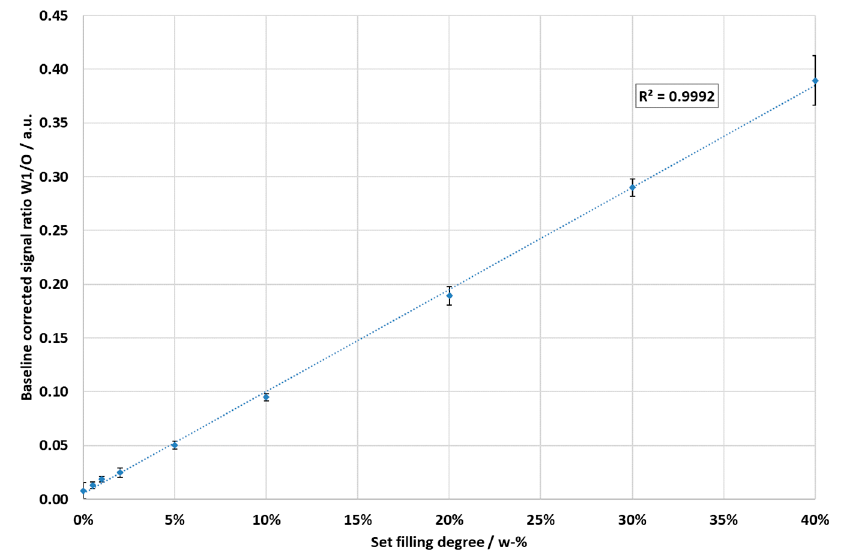
Figure 5. Result of the filling degrees calculated from the measured data plotted against the set filling degrees. Each data point is based on four measurements. The data show a very high linearity with a coefficient of determination of R 2 = 0.9992. The associated standard deviations are shown. However, all standard deviations are multiplied by a factor of three for improved